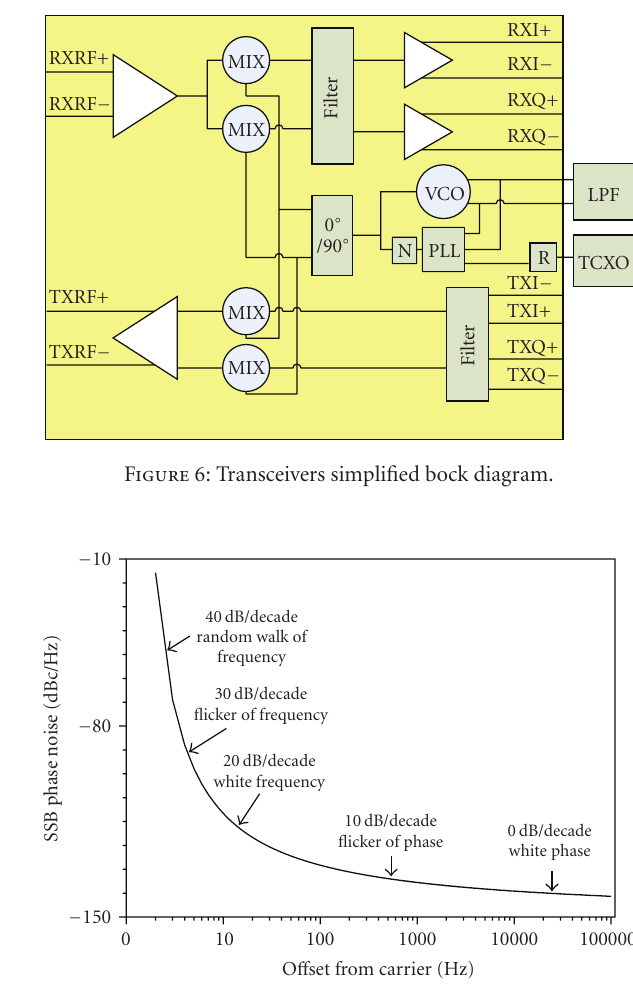
Figure 7: Typical phase noise curve for the low phase noise